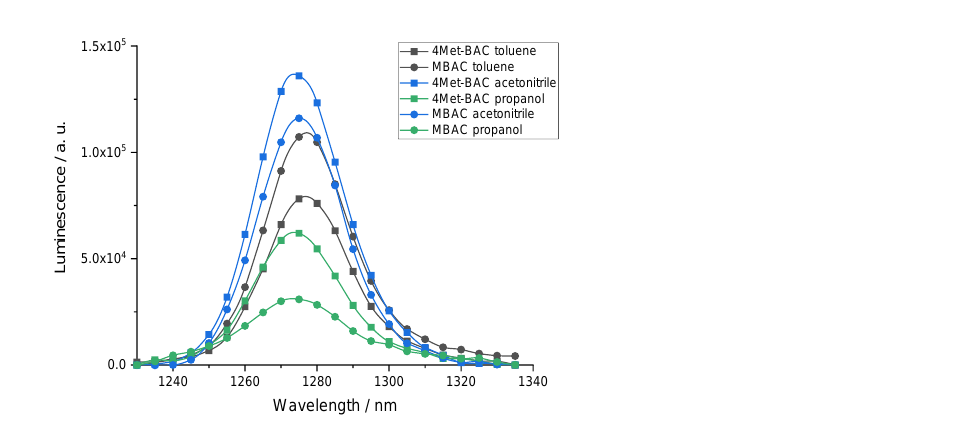
Figure 7. Singlet oxygen luminescence spectra of 4Met-BAC (6.0 × 10 −6 M) (- ■ -) and MBAC (6.0 × 10 −6 M) (- ● -) solutions in different solvents. Excitation at 438 – 470 nm using a Xe lamp.